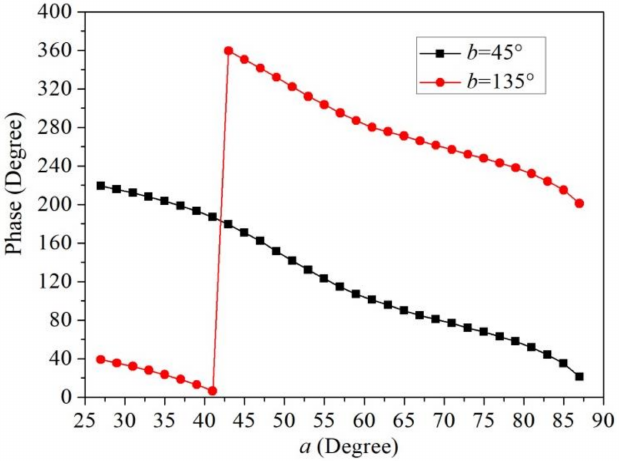
Figure 5. Simulated 10-GHz reflection phase distributions of a reflect surface unit cell.